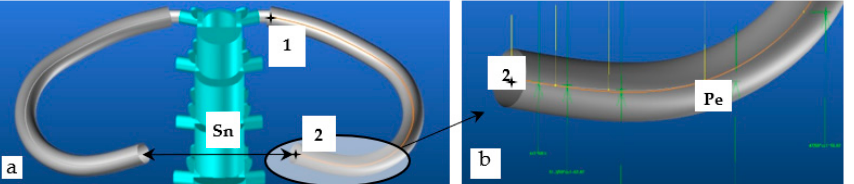
Figure 7. The ( a ) developed similar ribs by sternum width Dx, and ( b ) the elasticity zone of the costal cartilage.